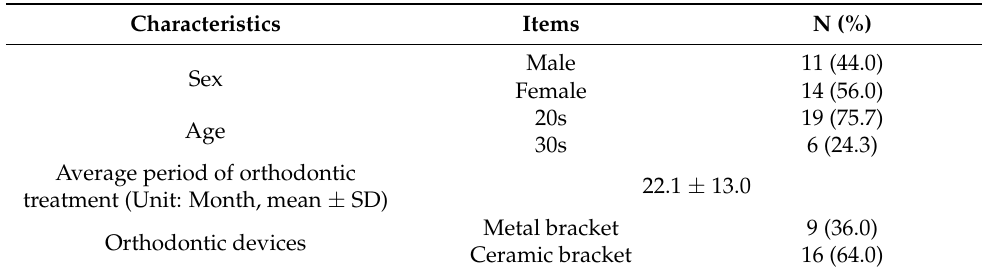
Table 2. General characteristics of the